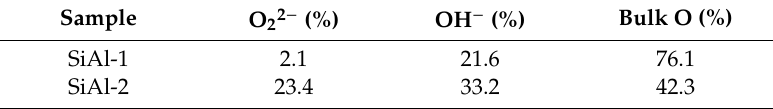
Table 1. O 1s content of di ff erent species in SiAl-1 and SiAl-2 from XPS.